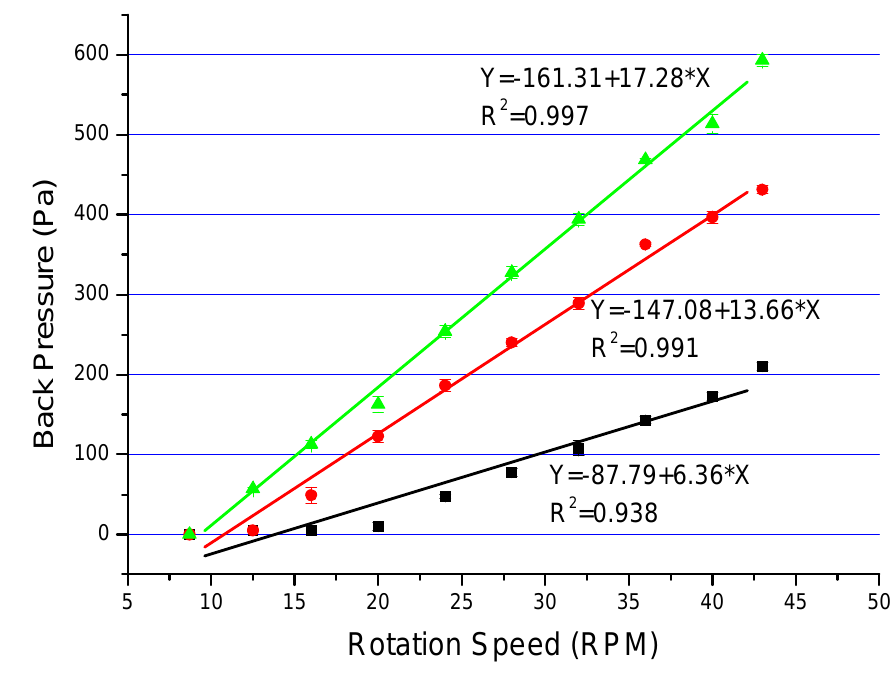
Figure 6. Back pressure vs rotation speed with different ball bearing size.